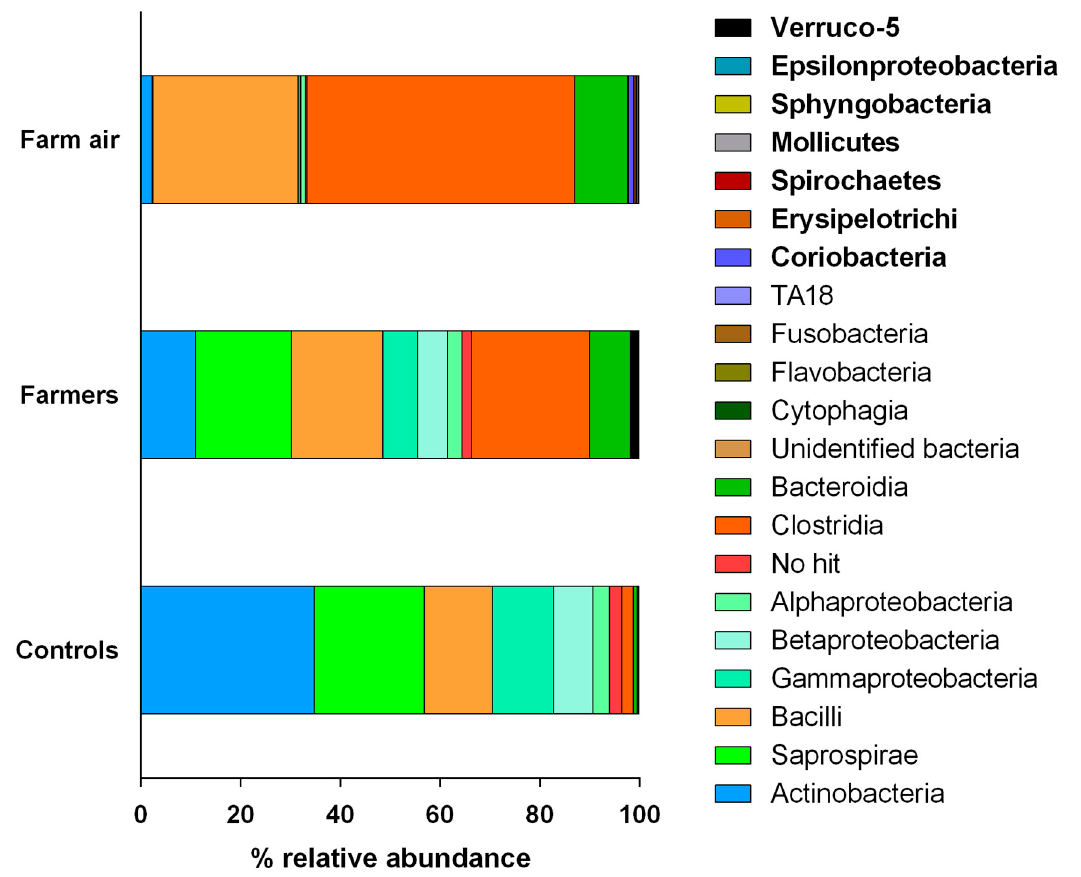
Figure 5. Taxonomic profile showing the relative abundance of each bacterial class across nasopharyngeal flora samples from pig farmers, non-exposed controls and air samples from pig buildings. Taxa written in bold type were specific to farmers and air from pig